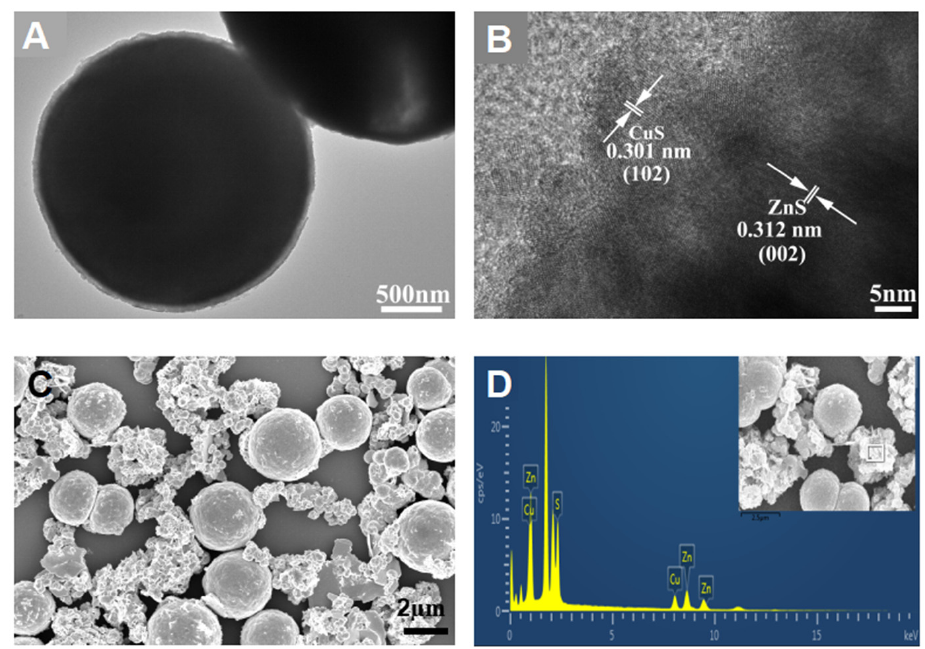
Figure 1. TEM image ( A ), high-resolution TEM image ( B ), SEM image ( C ), and EDS spectra ( D ) of the p-CuS/n-ZnS.